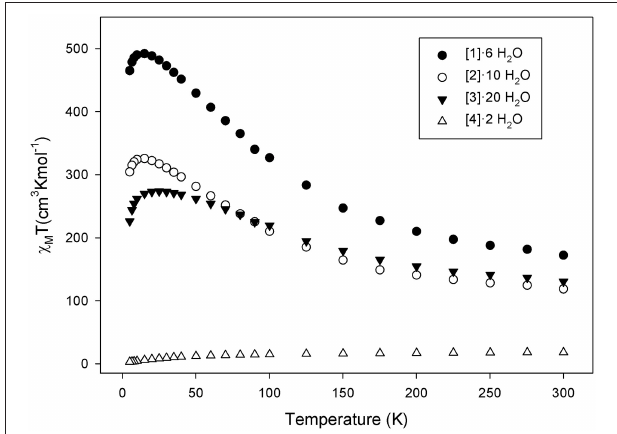
FIGURE 3 | χ M T vs. T plots for complexes ( 1 ) · 6 H 2 O (•), ( 2 ) · 10 H 2 O ( ◦ ), ( 3 ) · 20 H 2 O ( H ), and ( 4 ) · 2 H 2 O ( 1 ) in the temperature range 5–300K in a 0.1T applied dc